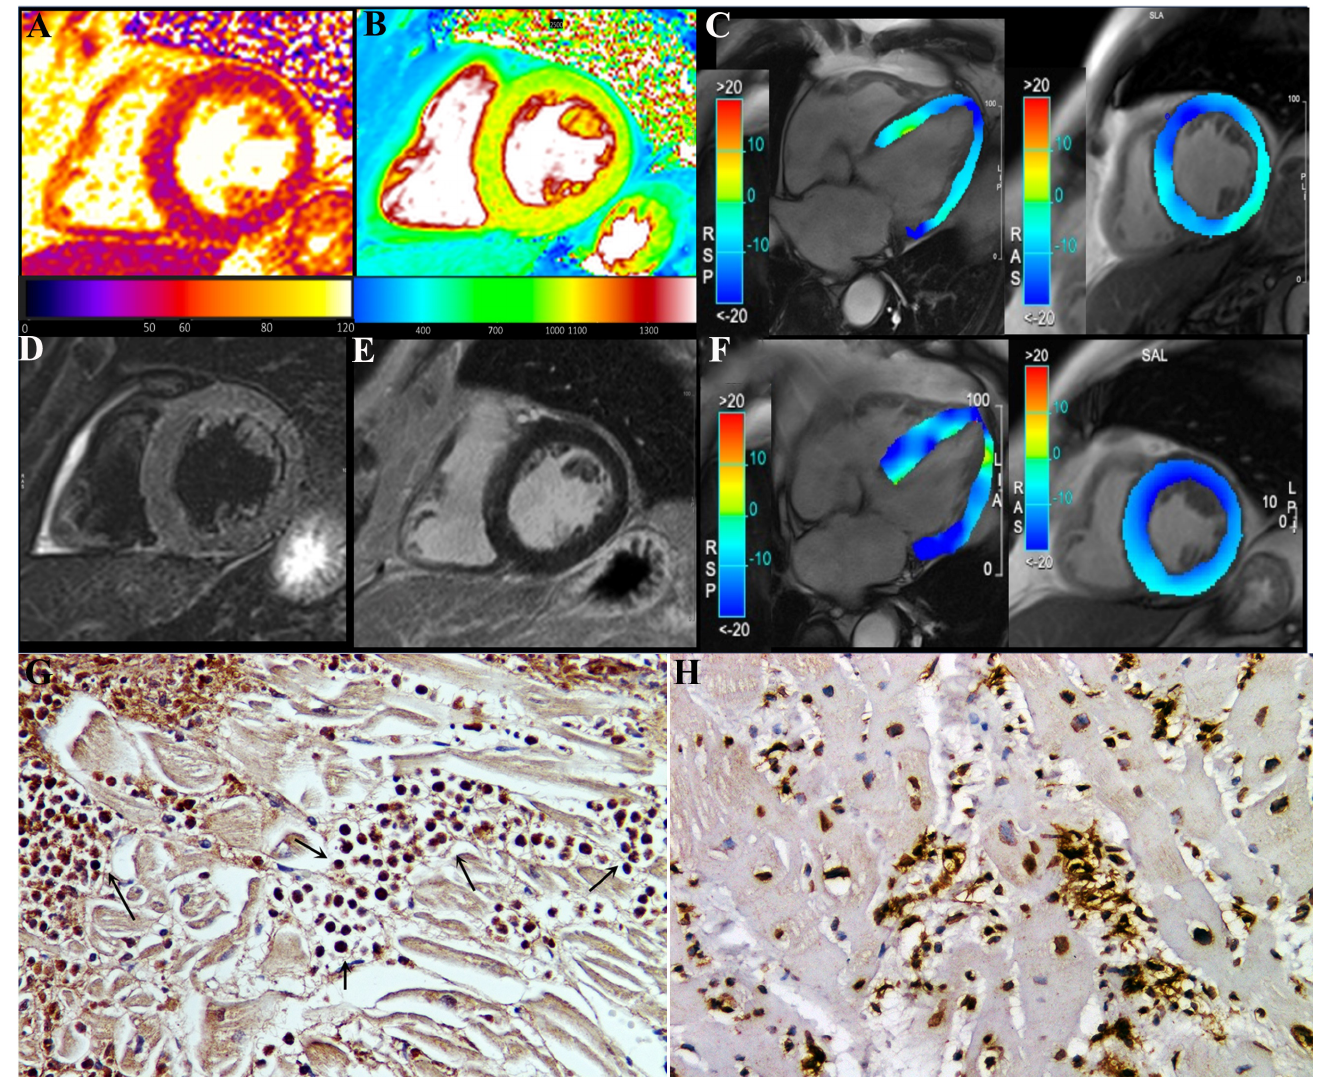
Figure 3. A 78-year-old male (pt2) with eosinophilic myocarditis myocarditis after second dose of COVID-19 mRNA (BNT162b2) vaccine. At first CMR exam ( A – E ), performed 4 weeks after symptoms onset, T2 (Panel A) and native T1 (Panel B) maps revealed an increase in global T2 (55 ms ± 4 ms, normal range < 49.9 ms) and T1 (1060 ± 15 ms, normal range < 1027 ms) myocardial values, without any noticeable focal areas of signal changes on STIR T2-weighted (Panel D) and late-gadolinium-enhanced (Panel E) images, reflecting mild diffuse edematous condition. CineMR images, acquired on four-chamber (left) and mid-ventricular short-axis (right) views, analyzed by tissue tracking analysis show moderate impairment of both longitudinal and circumferential systolic left ventricular function (GLS: − 12.3%, GCS: − 13.6%, EF: 35%) at admission (Panel C), which improved at two-month follow-up after therapy (Panel F, GLS: − 18.1%, GCS: − 17.8%, EF: 49.5%). GCS: global circumferential strain; GLS: global longitudinal strain; EF: ejection fraction. ( G ) shows in post-vax myocarditis massive eosinophilic myocardial infiltration with necrosis of the adjacent myocytes (IHC for eosinophil major basic protein (EMBP) antibody). (200× magnification). ( H ): Comparison with acute myocarditis associated to COVID19 infection showing intense lymphocytic inflammation (IHC for CD45Ro) ( 200x magnification ).